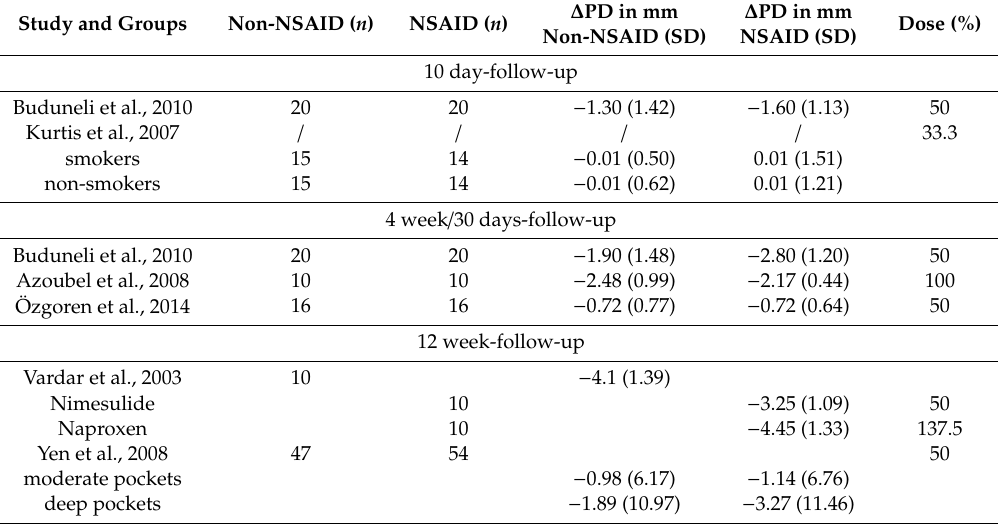
Table 3. Probing pocket depth in comparison to non-NSAID and NSAID groups at three di ff erent follow-up